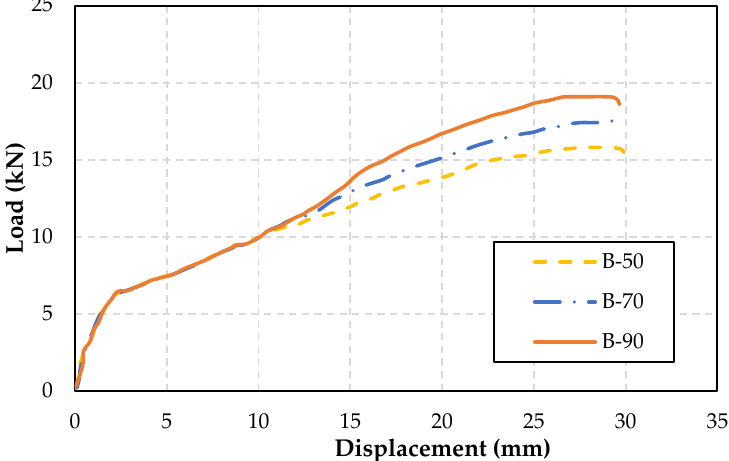
Figure 9. Effect of concrete compressive strength on the behavior of GFRP-strengthened slabs.